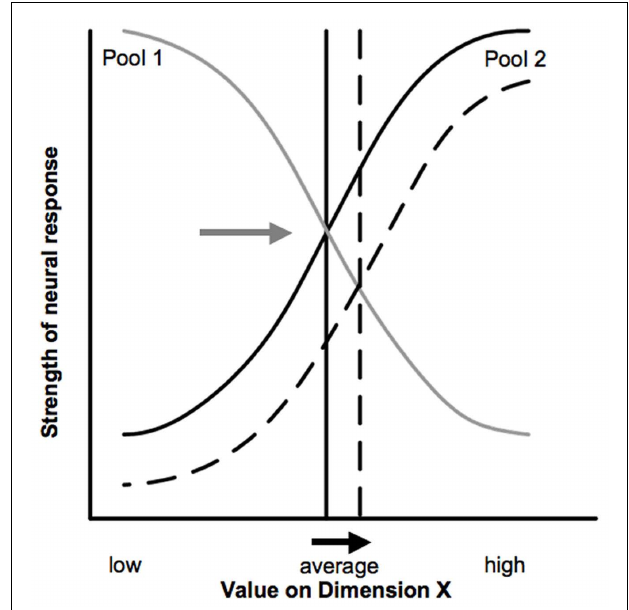
FIGURE 1 | Model of adaptive coding adapted from Rhodes et al.